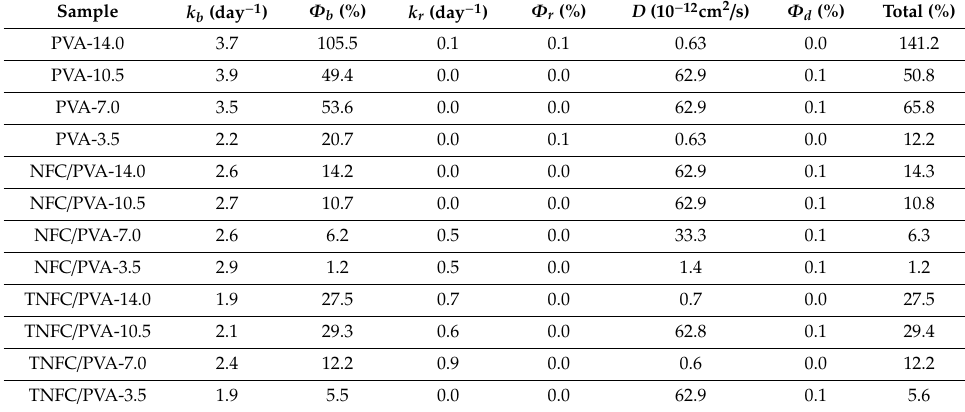
Figure 5. Fitting of triphase release mechanism (Equation (1)) to experimental drug release data based on drug concentration: 14.0 mg / mL (top left), 10.5 mg / mL (top right), 7.0 mg / mL (bottom left), and 3.5 mg / mL (bottom right). Table 4. Values estimated in MATLAB from fitting the multiphase release equation (Equation (1)) to experimental data. MATLAB inputs were average values from each time point.